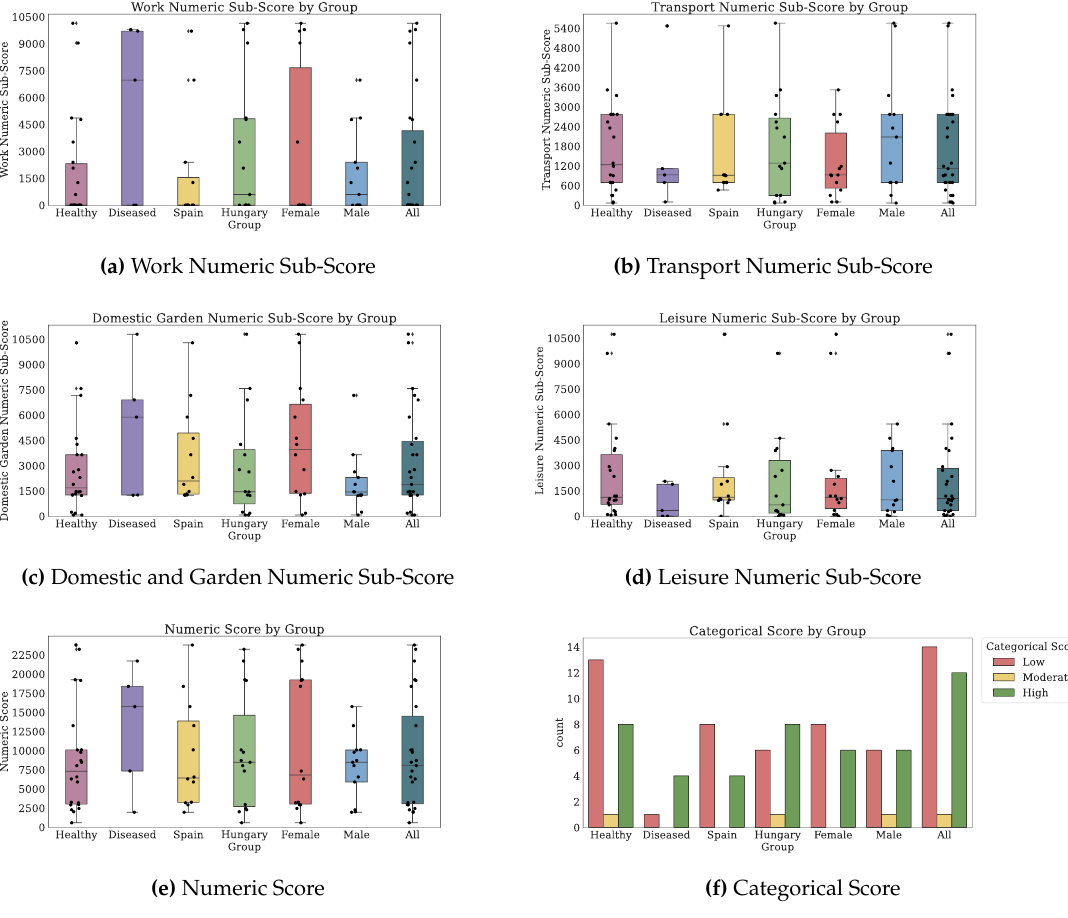
Figure A3. Sub-scores and Scores for Physical Activity (IPAQ)